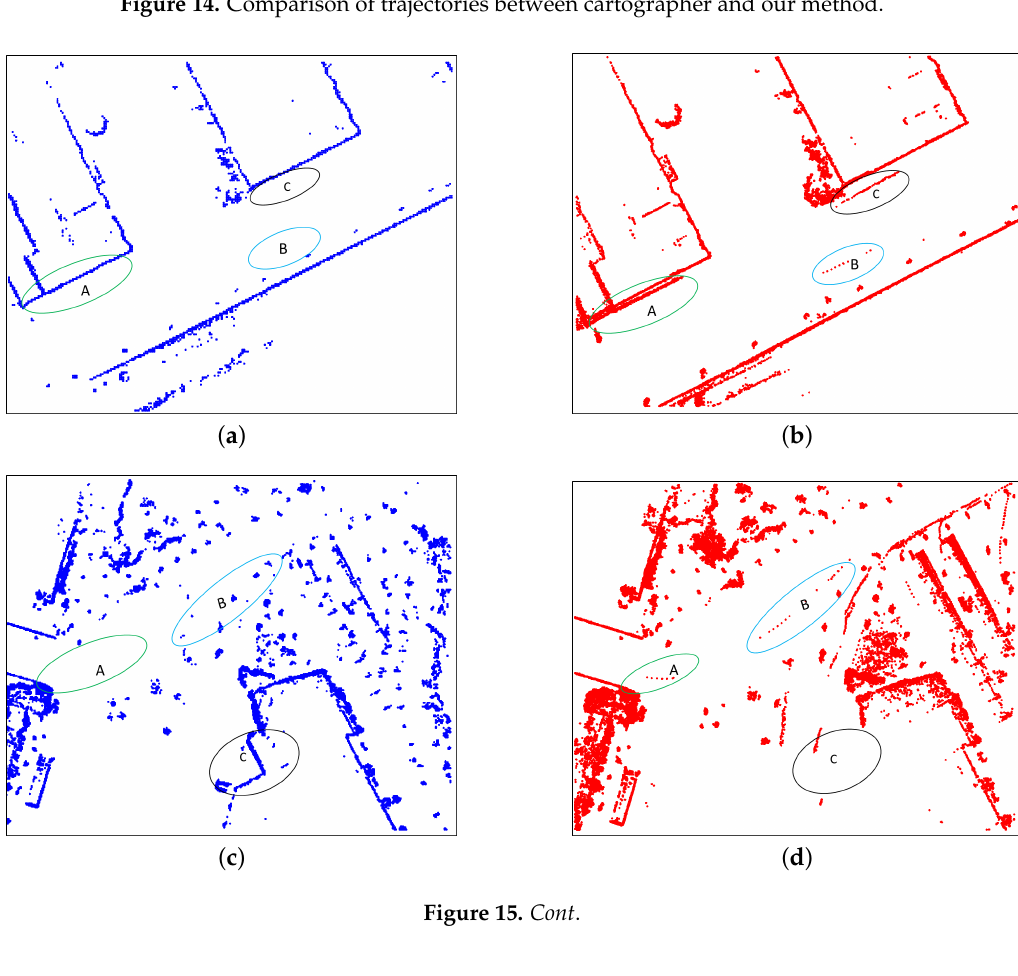
Figure 14. Comparison of trajectories between cartographer and our method.